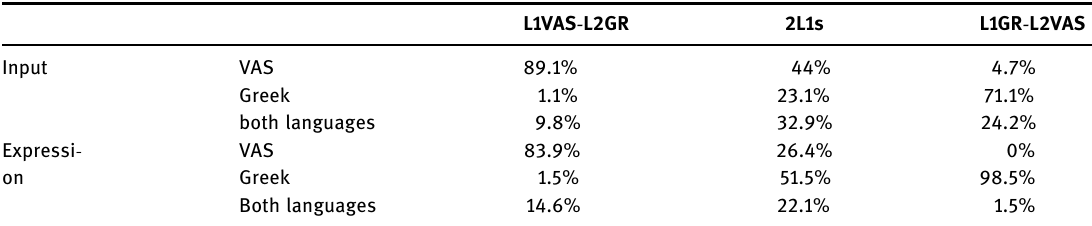
Table 3: Current language practices per bilingual